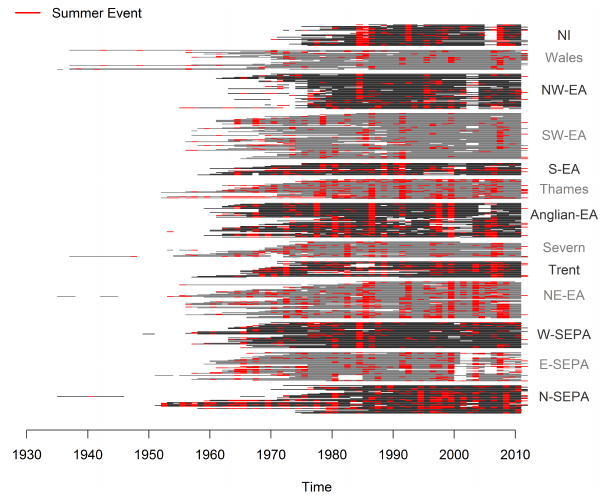
Fig. 1. Time coverage for the annual maximum river peak flow se- ries. Events occurring in summer are indicated in red.